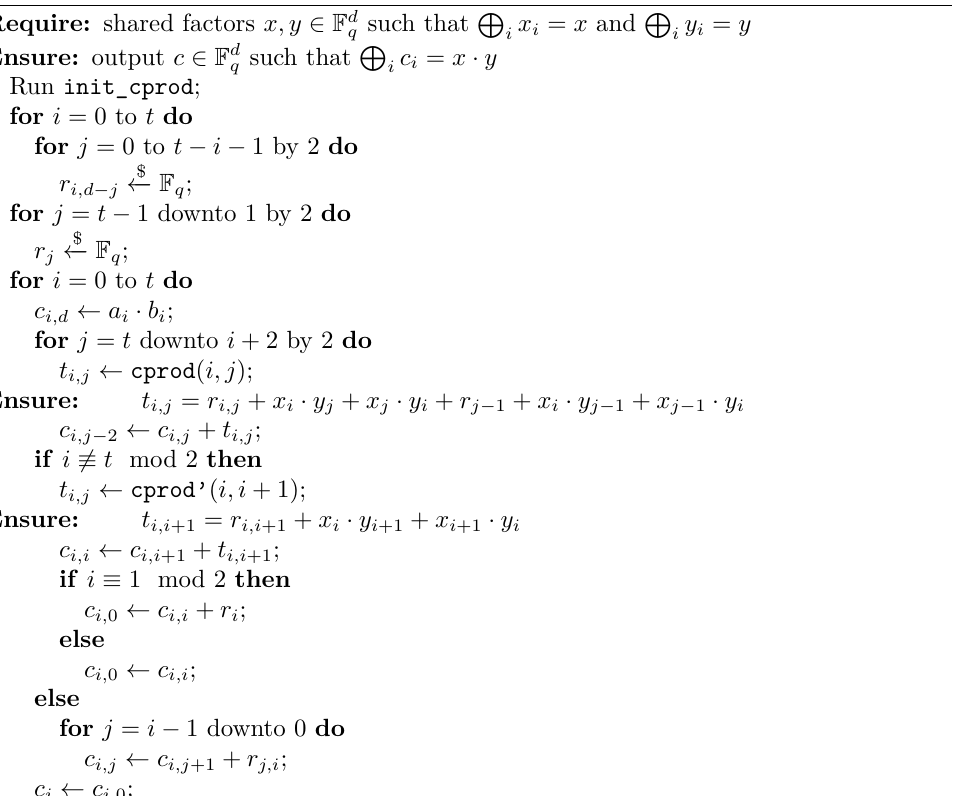
Algorithm 4 Multiplication gadget over d shares with reduced randomness for Compression stage. Parameterized with three sub-algorithms init_cprod , cprod and cprod’